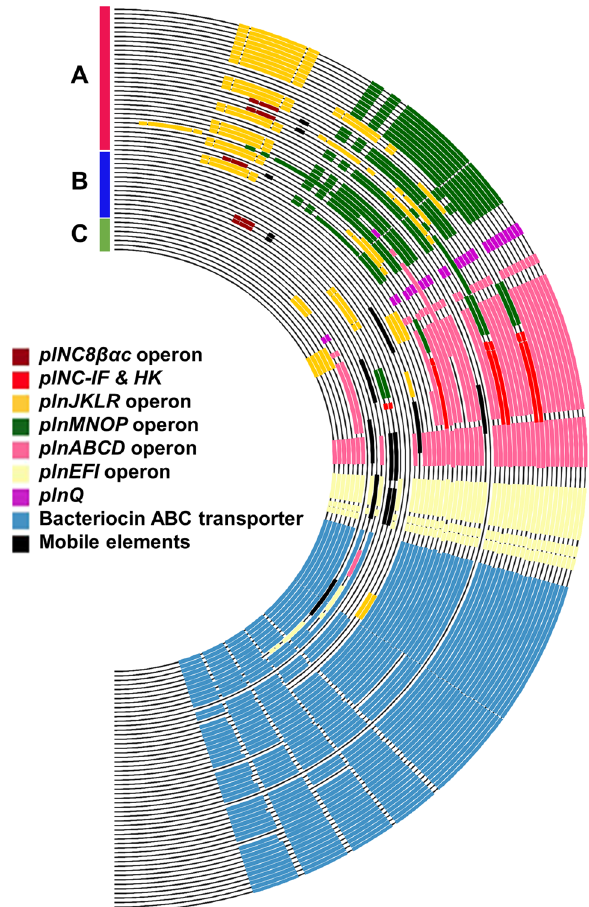
Figure 3. Plantaricin gene ( pln ) loci observed in the 54 complete genomes of Lactiplantibacillus plantarum subsp. plantarum . The genes related to the biosynthesis and transport systems of plantaricin were